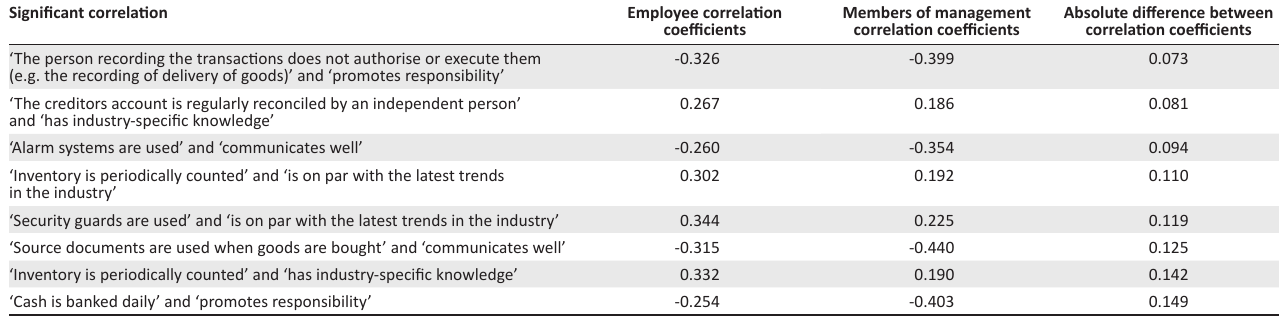
TABLE 2: Summary of similar significant correlations between members of management and employees. Significant